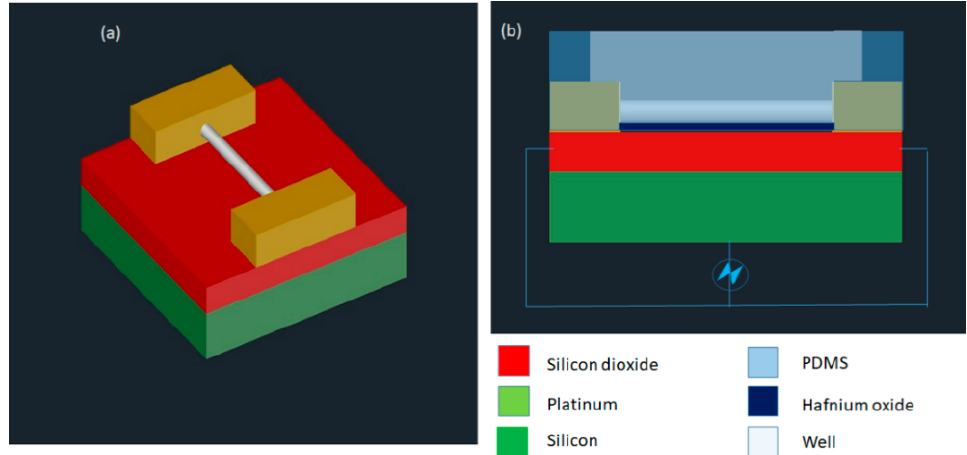
Figure 15. ( a ) Device design is shown in the diagram. ( b ) Electrical schematic diagram of the device. Figure has been redrawn from ref. [115].